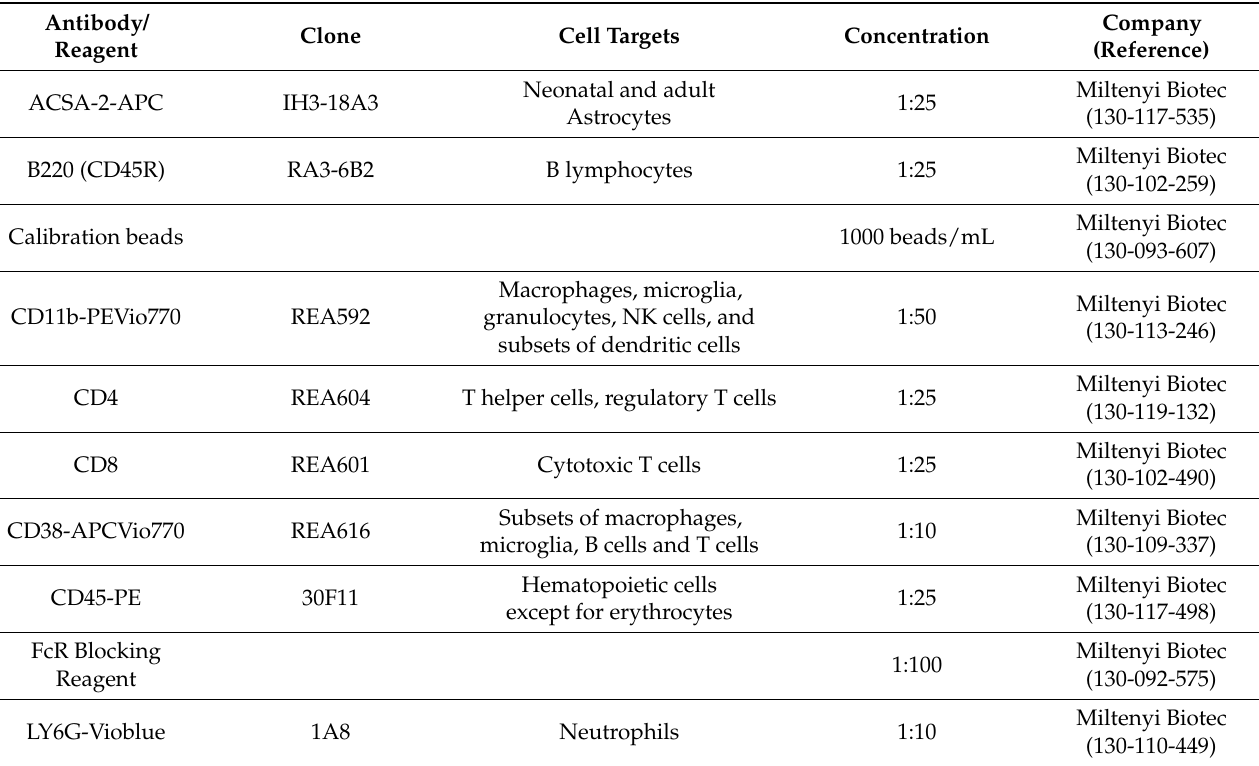
Table 2. Antibodies and reagents used for flow cytometry